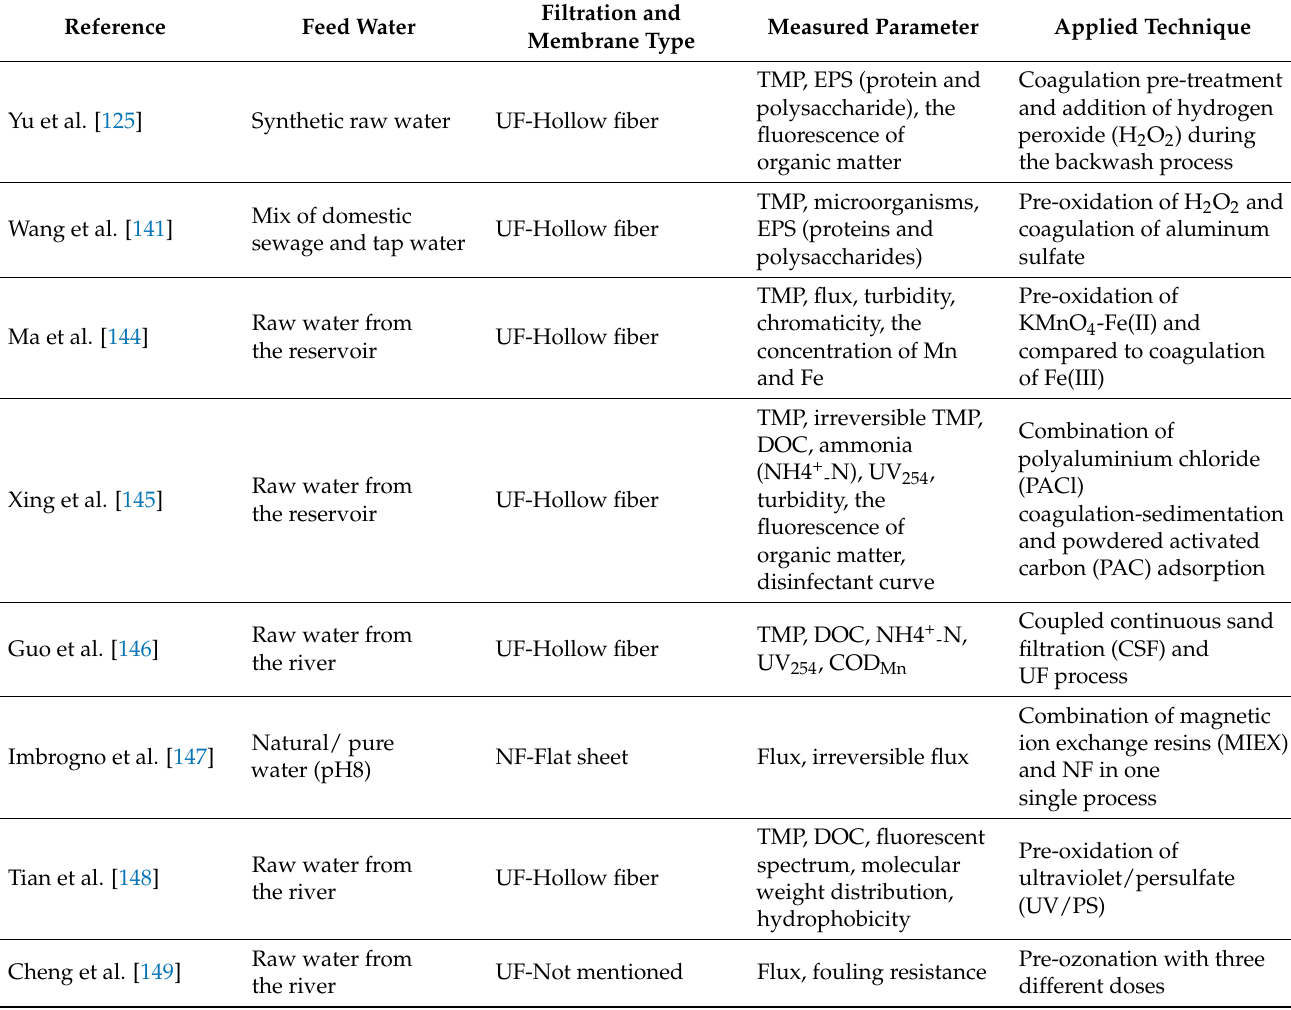
Table 5. Setting of membrane fouling prevention in drinking water